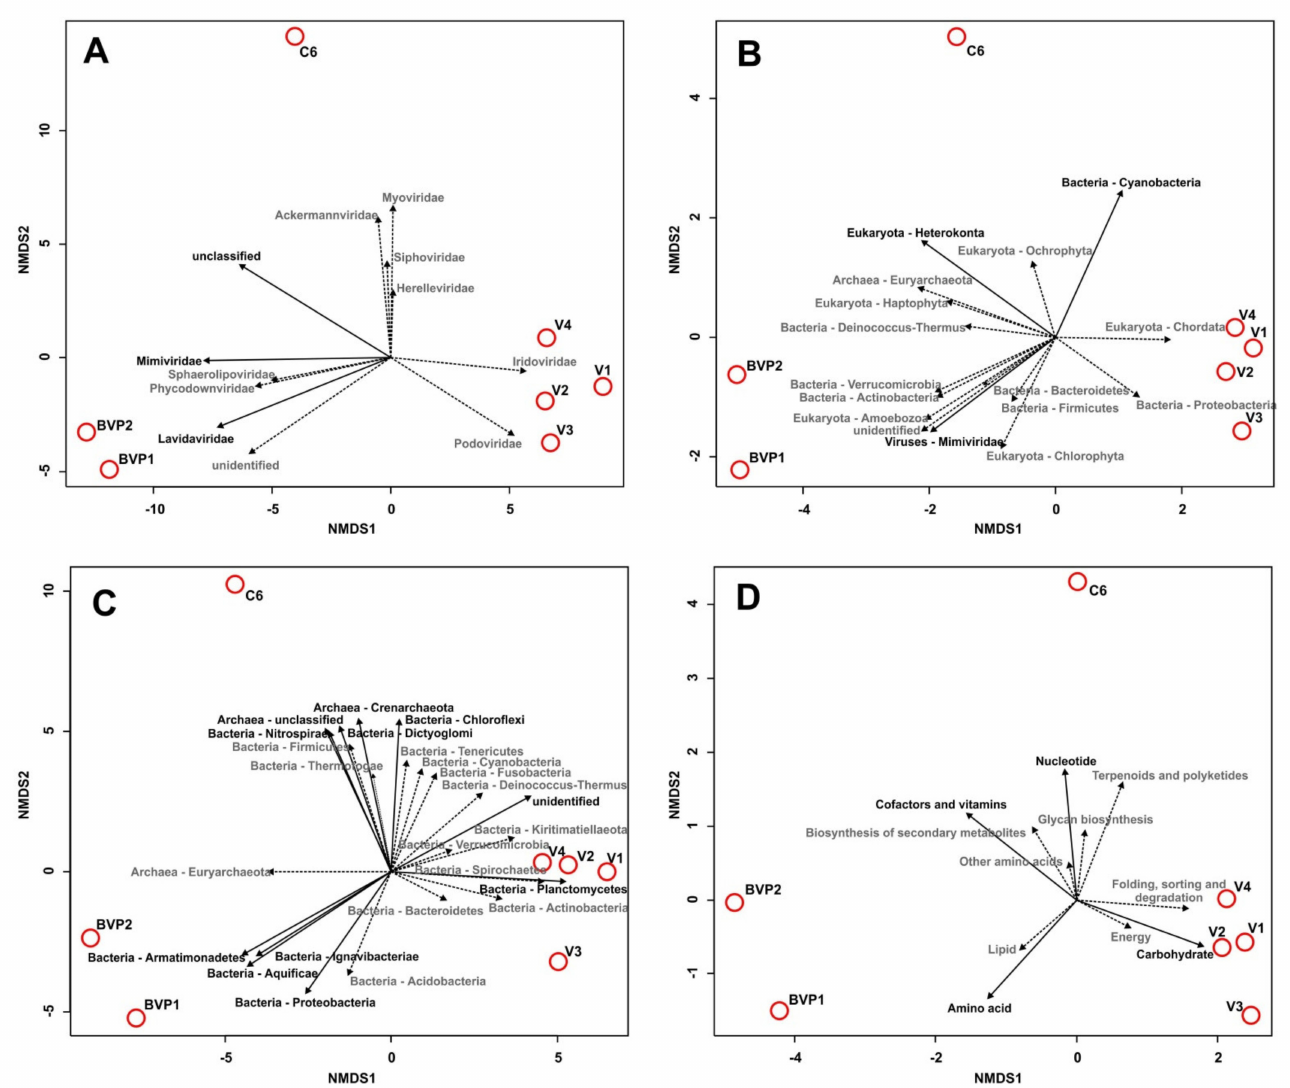
Figure 5. Non-metric multidimensional scaling (NMDS) biplots of the Baikal virome samples showing the following results: ( A )—taxonomic analysis of viral scaffolds (vectors indicate the viral families); ( B , C )—viral host prediction, carried out using the Virus–Host database and the VirHostMatcher-Net software, respectively (arrows show the phyla of putative host); and ( D )—AMGs analysis (vectors are the metabolic categories). Unreliable vectors are marked with a dotted line and grey